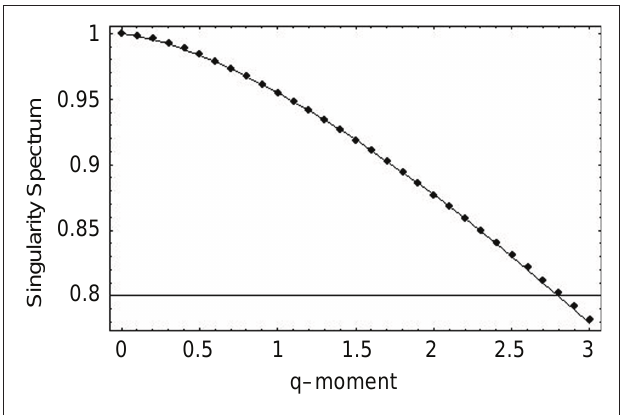
Figure 6 | The singularity spectrum for q > 0 obtained through the numerical fit to the human gait data. The curve is the average over the ten data sets obtained in the experiment (Peng et al., 1993).